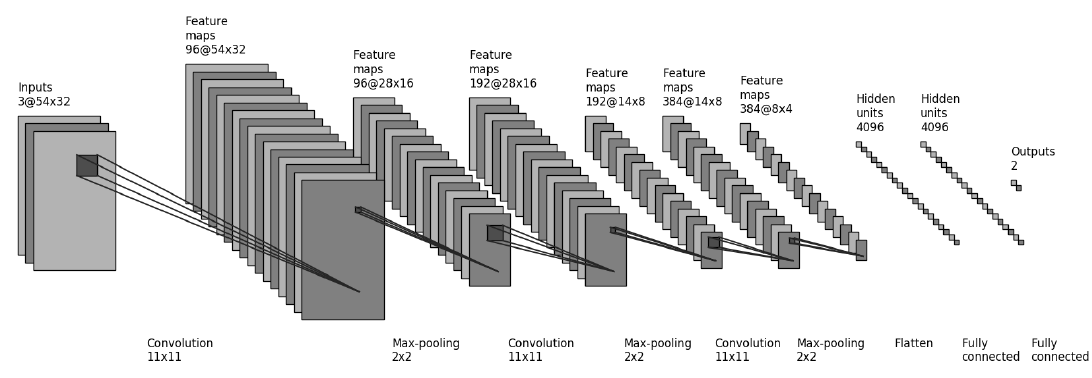
Figure 7. CarNet